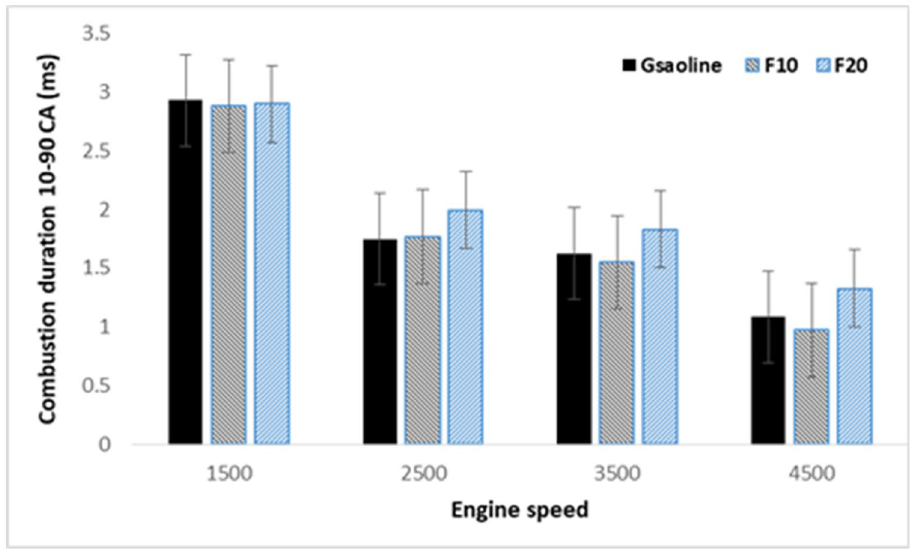
Figure 10. Combustion duration of CA10–90% heat release against engine speeds and three different